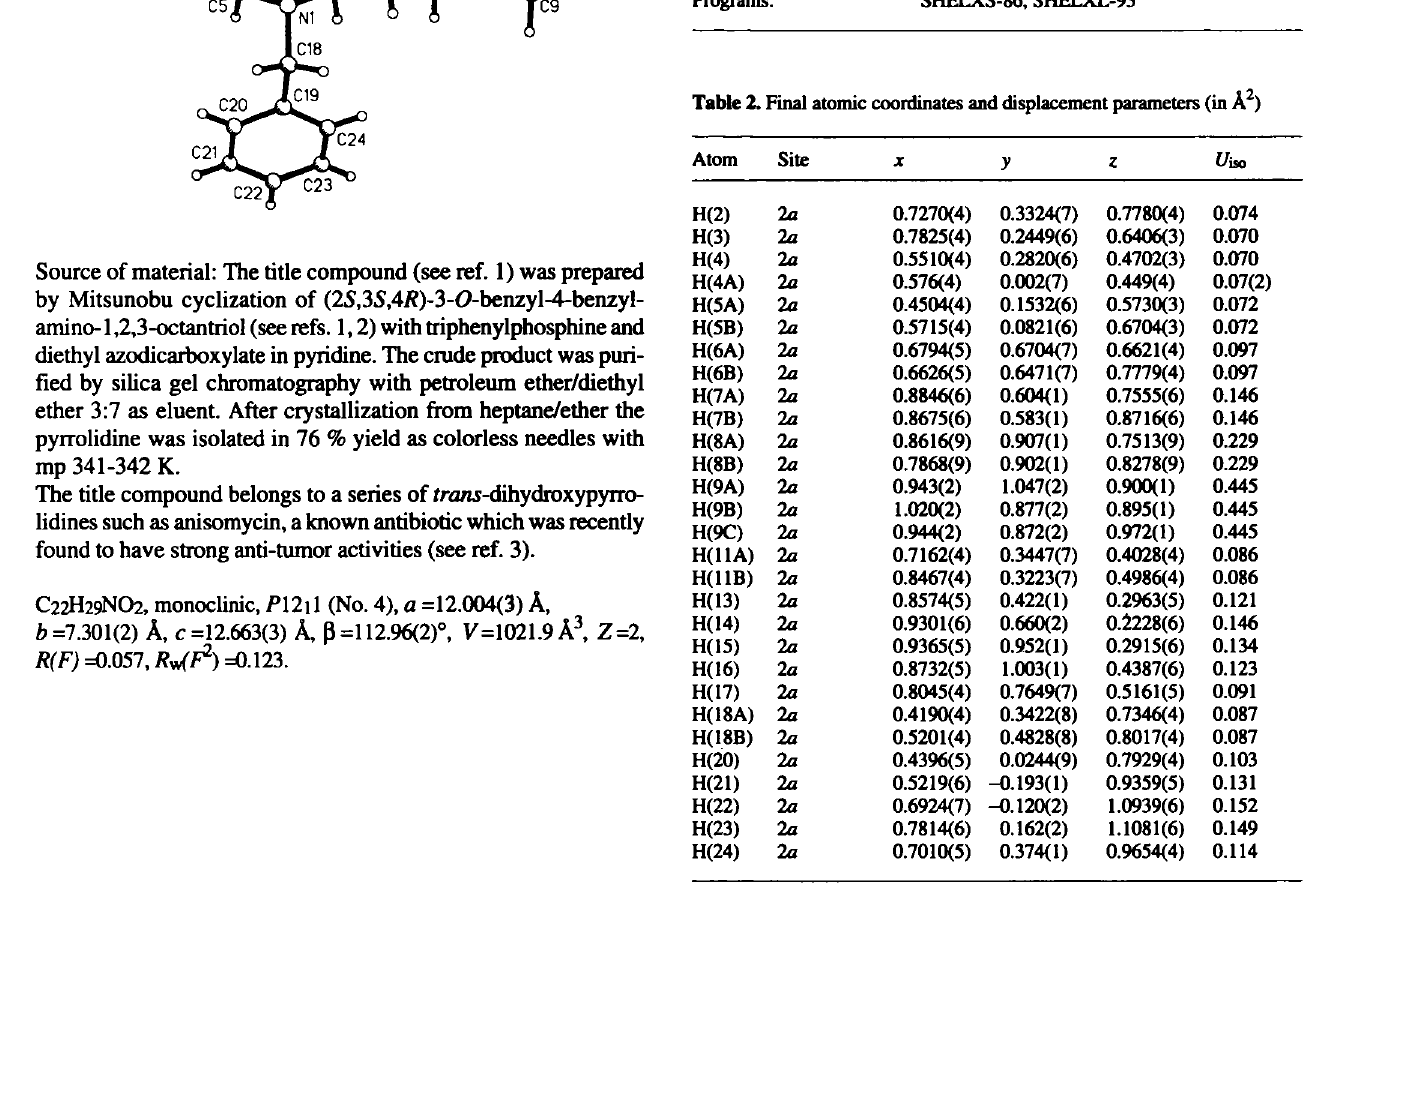
Table 1. Parameters used for the X-ray data collection Crystal: